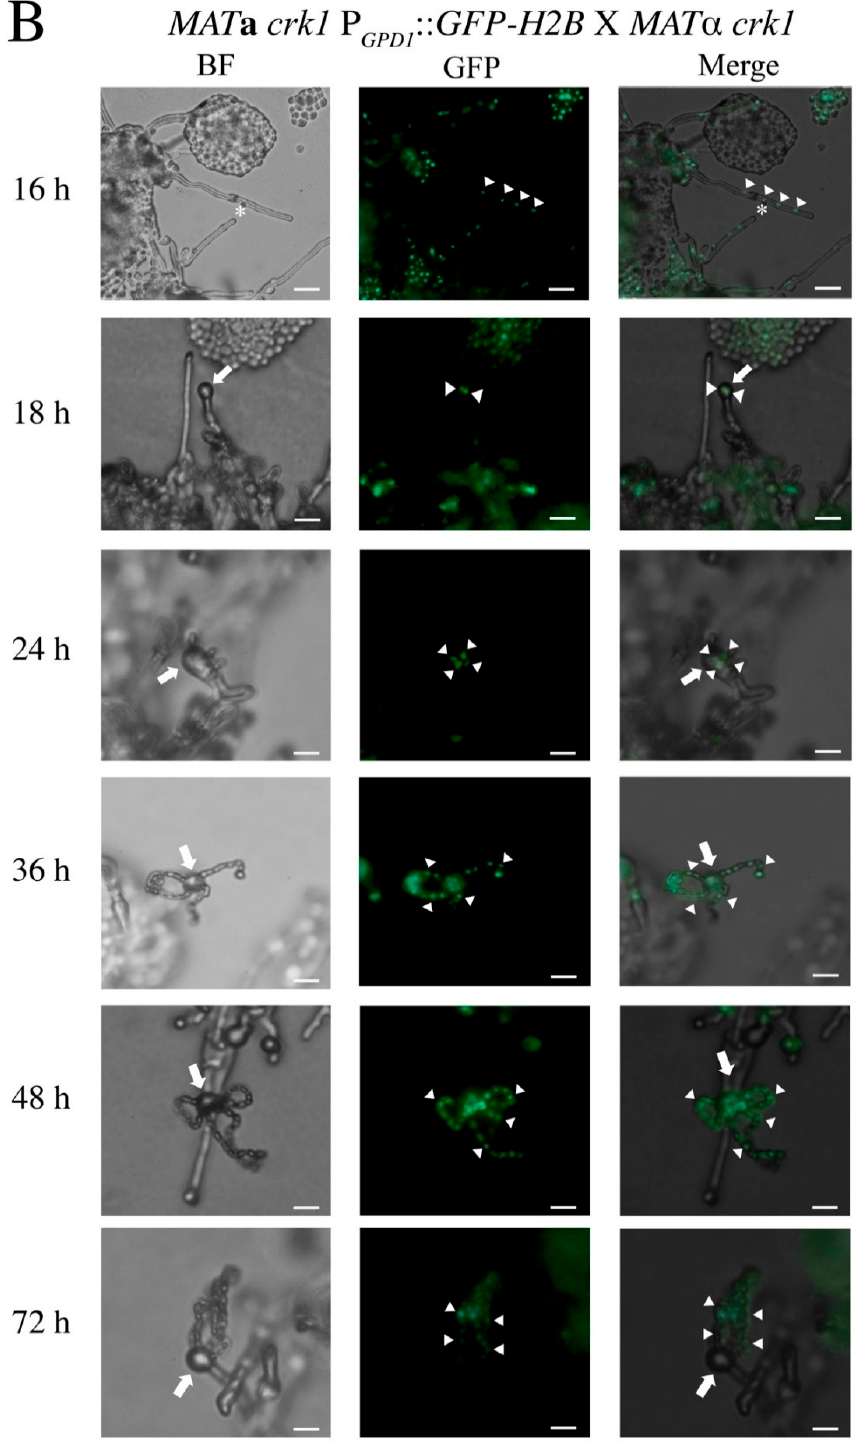
Figure 1. Nuclear distribution in the mating structures of the wild-type and bilateral crk1 mutant crosses during bisexual mating process. Mating of the wild-type ( A ) and bilateral crk1 mutant ( B ) crosses was conducted on V8 solid medium and incubated at 26 ◦ C. Nuclei were visualized by Gfp-H2b fusion protein in the MAT a wild-type and MAT a crk1 mutant cells. Bright-field (BF) and fluorescent (GFP) images of dikaryotic filaments, basidia and long chains of basidiospores were photographed at 400 × magnification. Photos taken from 16 to 72 h were shown and merged photos were created with ImageJ. White star indicates clamp cell, white triangle indicates nucleus, and white arrow indicates basidia. Scale bar = 5 µ